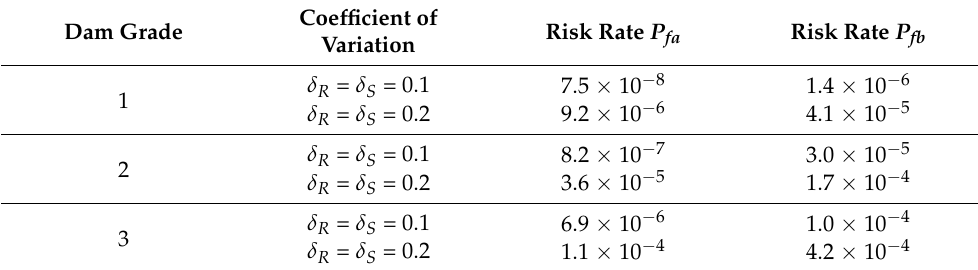
Table 1. Risk thresholds of instability failure for earth–rock dams [39].